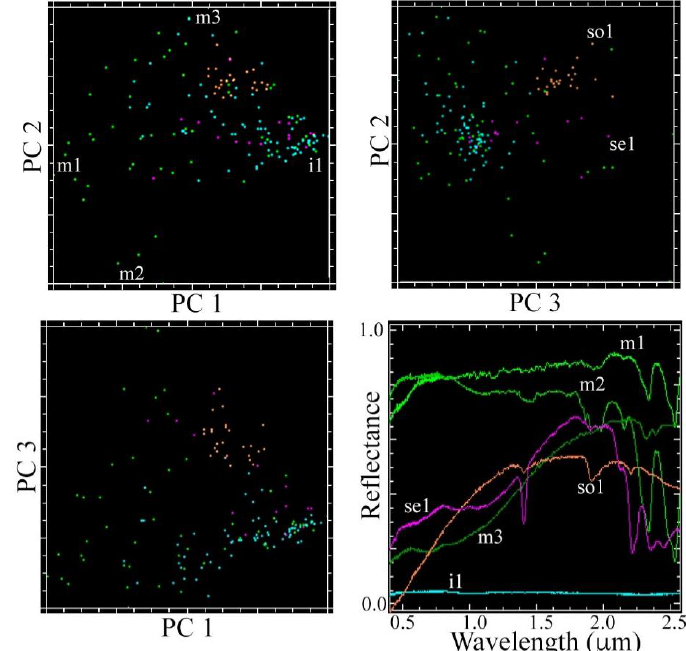
Figure 6. Spectral feature space and endmembers for the rock and soil substrate spectra from the JHU spectral library. Visible/NIR/SWIR false color composite ( top ) gives some indication of the spectral diversity in three principal wavebands. Three orthogonal projections of the spectral feature space ( bottom ), along with example endmember spectra from the periphery of the space, illustrate the broad diversity of metamorphic spectra compared to the more continuous soil